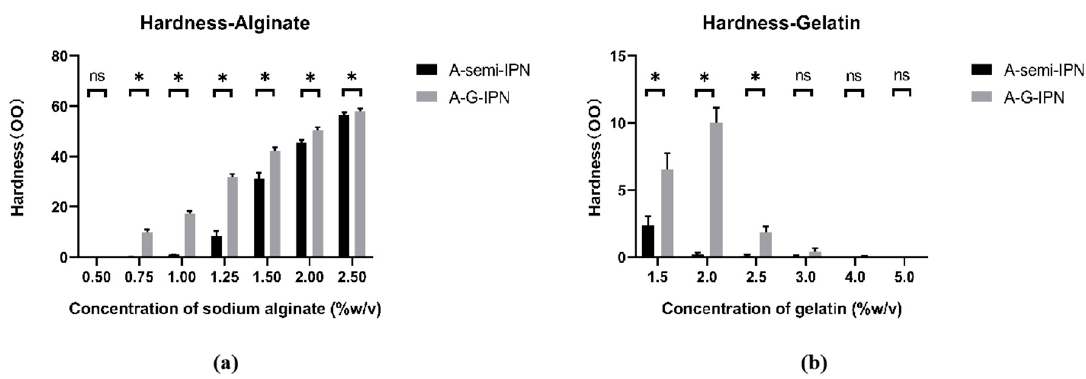
Figure 5. Hardness of the alginate-semi-interpenetrating polymer network (A-semi-IPN), and alginate-gelatin-interpenetrating polymer network (A-G-IPN): ( a ) hardness of the A-semi-IPN and A-G-IPN with di ff erent alginate concentrations. ( b ) Hardness of the A-semi-IPN and A-G-IPN hydrogels with di ff erent gelatin concentrations. * means that there are statistical significances between the A-semi-IPN and A-G-IPN groups ( p < 0.05).